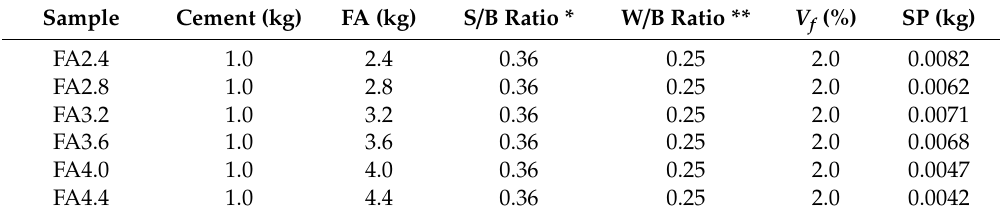
Mix proportion of high-volume fly ash strain-hardening cementitious composites (HVFA-SHCC).